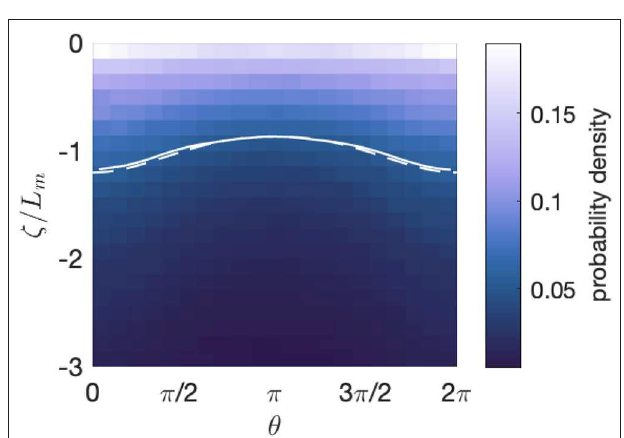
c ( θ , ζ ) for ǫ 0.2 = L m ( θ ) calculated from the e L m ( θ ) calculated from f f